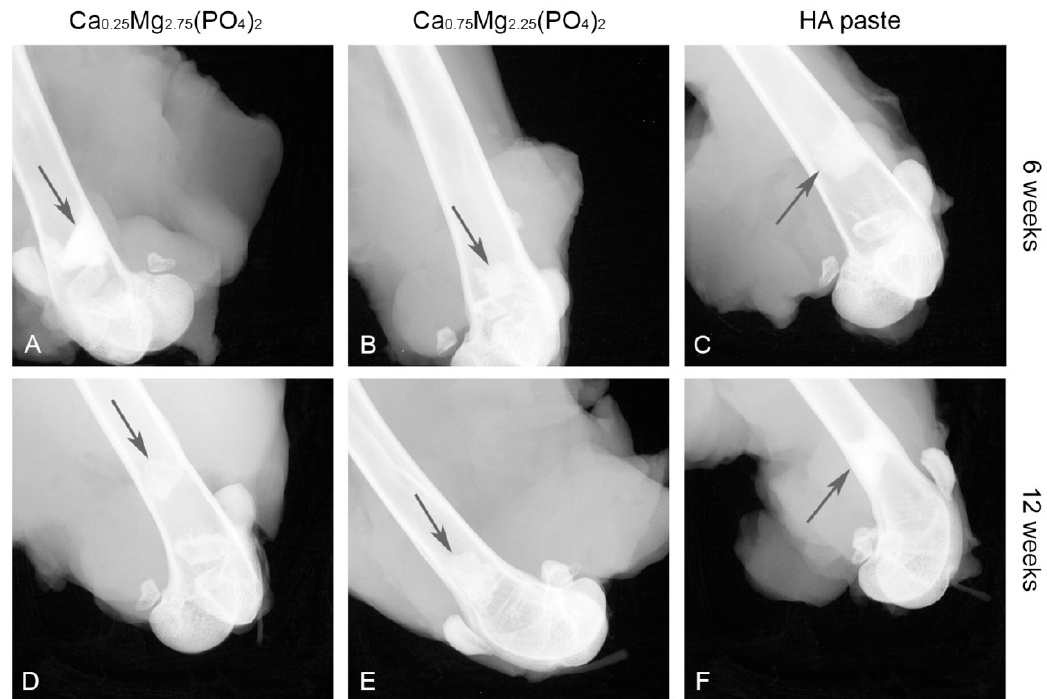
Figure 5. X-ray images of the Ca 0,25 Mg 2,75 (PO 4 ) 2 paste ( A , D ), the Ca 0,75 Mg 2,25 (PO 4 ) 2 paste ( B , E ) and HA paste ( C , F ) in the femoral defect directly after explantation after 6 and 12 weeks. The implants are marked by arrows.